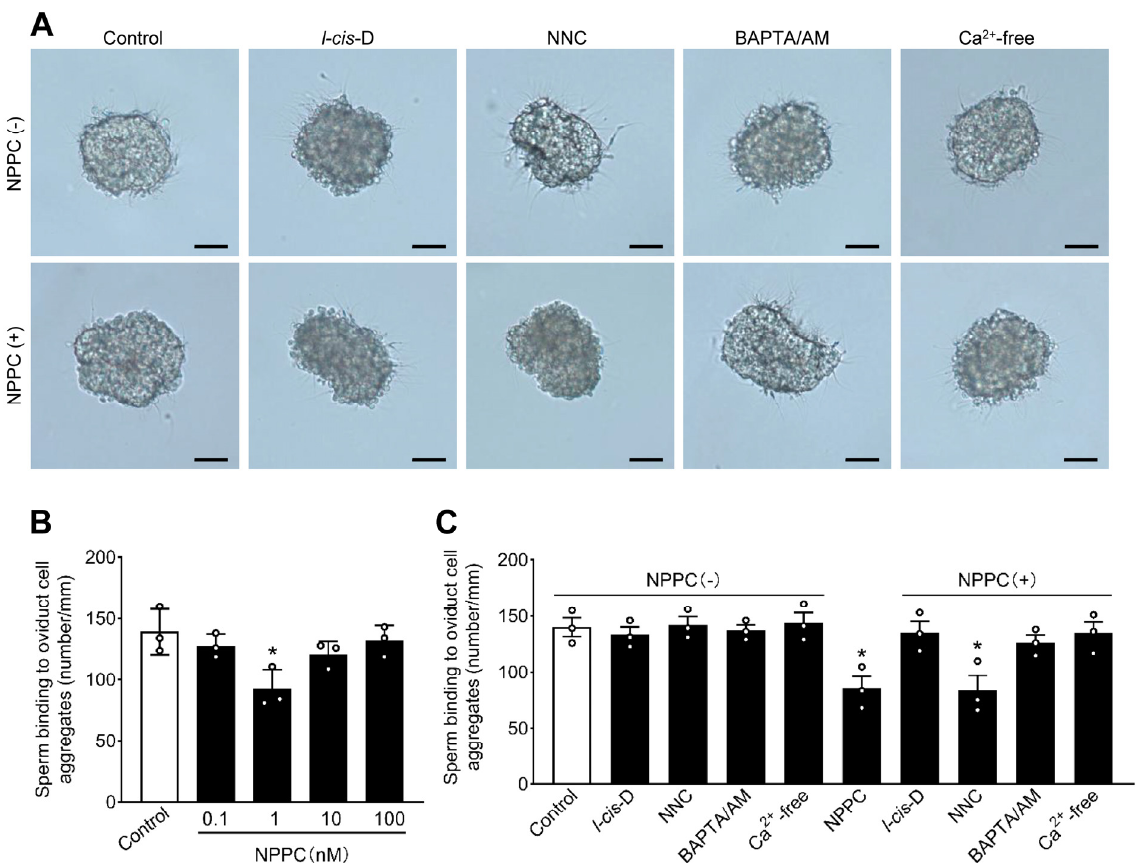
Figure 4. NPPC promotes sperm release from the oviduct isthmic cell aggregate. ( A ) Representative micrographs of spermatozoa-oviduct cell aggregate complexes after different treatments. Scale bars, 50 µ m. ( B ) The number of spermatozoa bound to the periphery of epithelial cells was measured after incubation with different concentrations of NPPC (0.1–100 nM) for 30 min at 39 ◦ C ( n = 3 independent experiments). ( C ) The number of spermatozoa bound to the periphery of epithelial cells was measured after incubation with different inhibitory treatments for 30 min at 39 ◦ C ( n = 3 independent experiments). NPPC, l-cis- Diltiazem ( l-cis -D), NNC 055-0396 (NNC), and BAPTA/AM were used with 1 nM, 50 µ M, 2 µ M, and 5 µ M, respectively. Bars indicate the mean ± SEM. Statistical analysis was performed by two-tailed unpaired Student’s t -test. * p < 0.05. Each data point represents a biologically independent